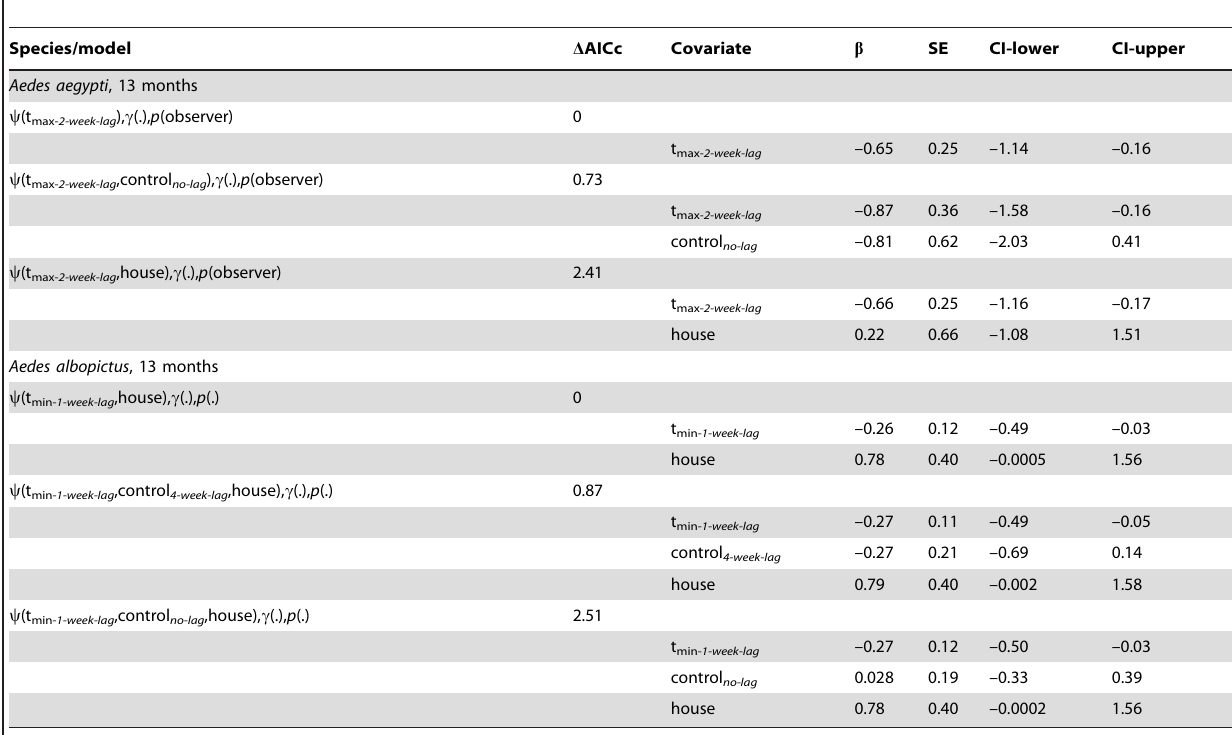
Table 1. Effects of control interventions, meteorological variables, and dwelling traits on infestation rates by dengue vectors: dynamic site-occupancy models fitted to a 13-month